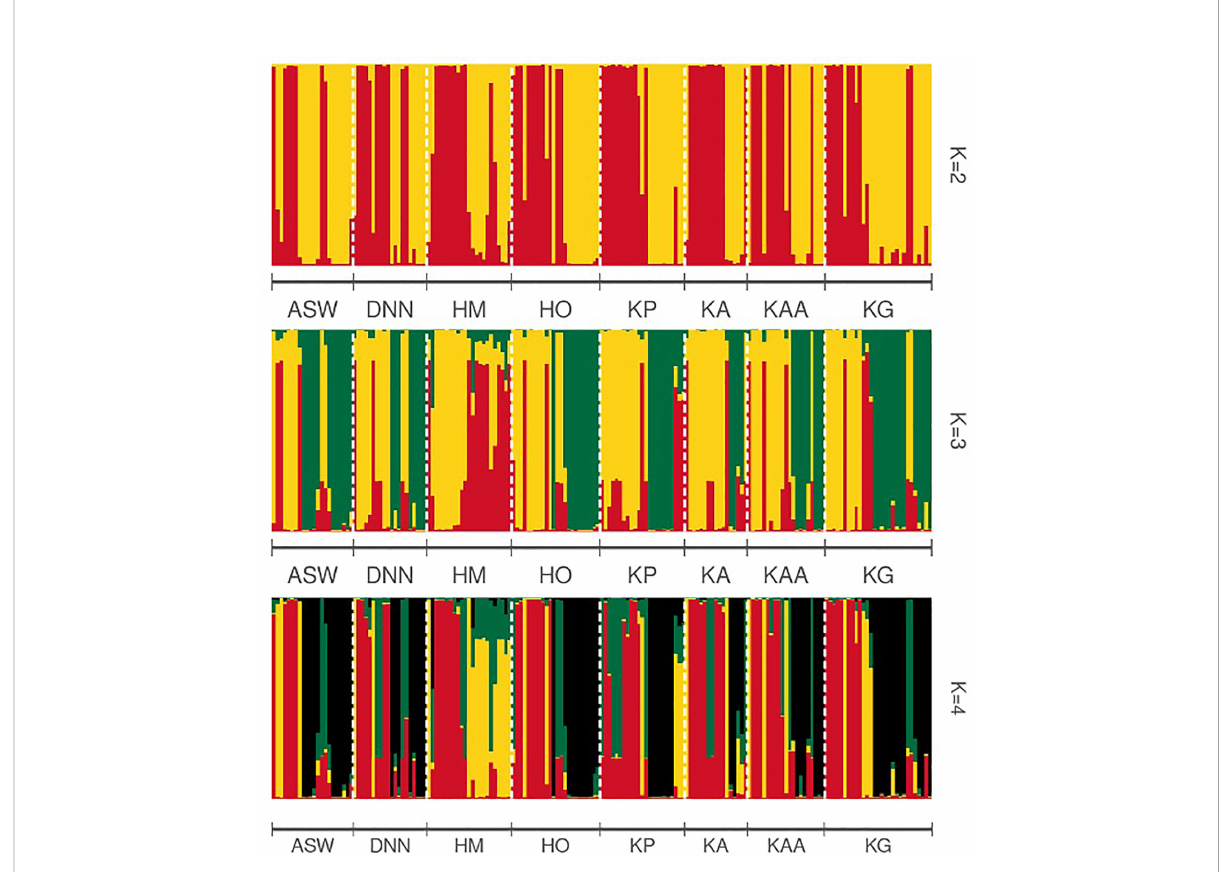
FIGURE 2 STRUCTURE bar plot for eight Cryptolepis sanguinolenta subpopulations showing results for (K=2-4). Each bar indicates the individual assignment probability of that individual belonging to one of the clusters indicated by different colors, based on twenty iterations. Evanno ’ s method indicated that two genetic clusters (K = 2) best explain the population structure in this species. Population designations are ASW, Asuafu-Sekyere West; DNN, Dromankese-Nkoranza North; HM, Hwehwee-Mempeasem; HO, Hwehwee-Oboyan; KP, Kwahu Pepease; KA, Kwahu-Abene; KAA, Kwahu-Atta n ’ Atta; KG, Krobo